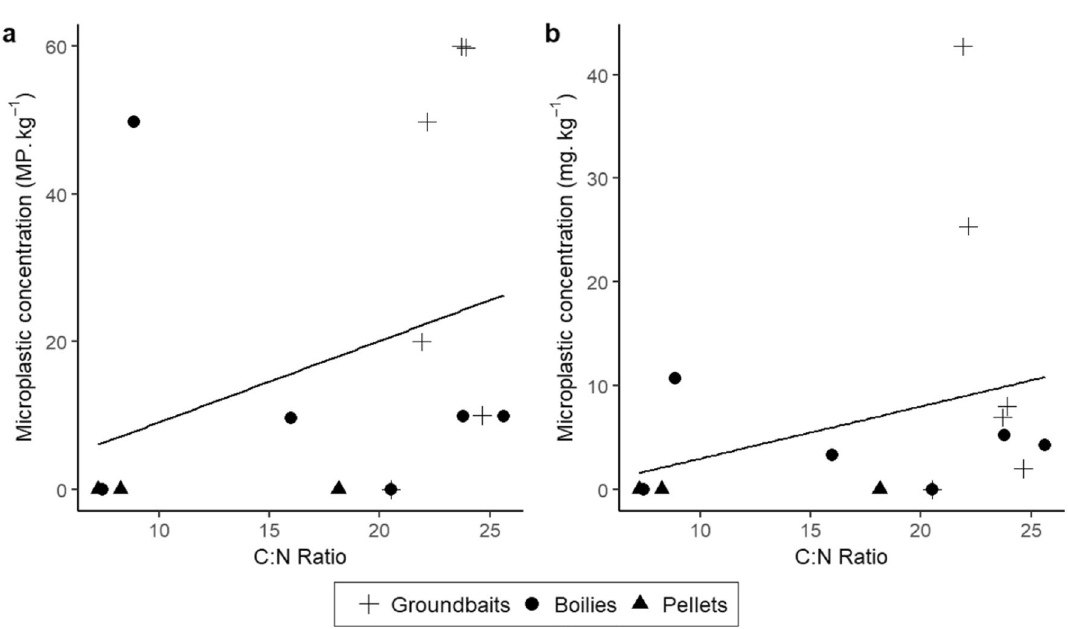
Figure 4. Relationship between average microplastic concentration (across all replicates) in ( a ) number (MP kg −1 ) and ( b ) mass (mg kg −1 ), and C:N ratio in angling baits. A lower C:N ratio indicates a higher proportion of animal-based